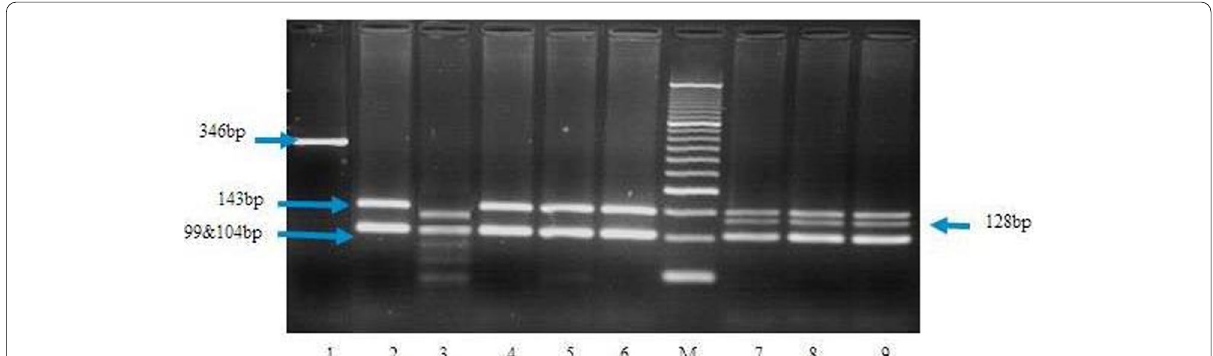
Fig. 2 A 3.5% agarose gel illustrating digestion of the PCR products with Tsp509I for detection of the rs12255372 polymorphism. Lane 1: undigested PCR product (346 bp). Lanes 2 and 4–6: 4 patients with the G/G genotype (143, 104, 99 bp). Lane 3: 1 patient with the T/T genotype (128, 104, 99, 17 bp). Lanes 7–9: three patients with the G/T genotype (143, 128, 104, 99, 17 bp). Lane M: size marker (50-bp DNA ladder, Fermentas, Germany)